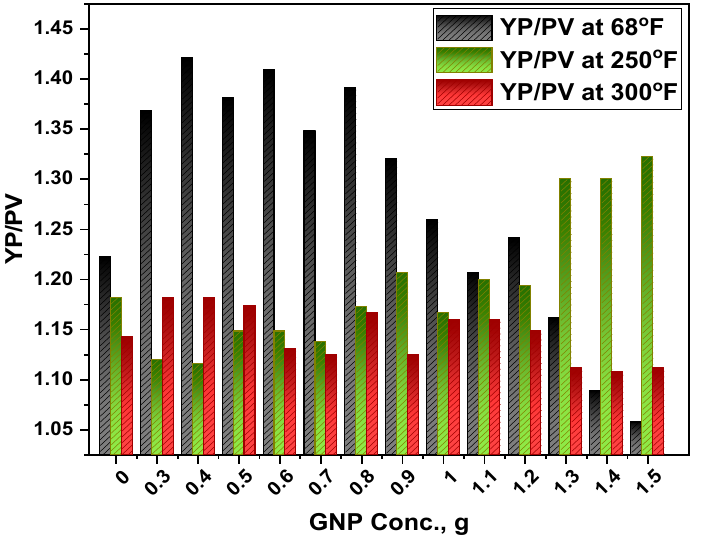
Figure 6. Response of GNP-Starch on the yield point/plastic viscosity (YP/PV).